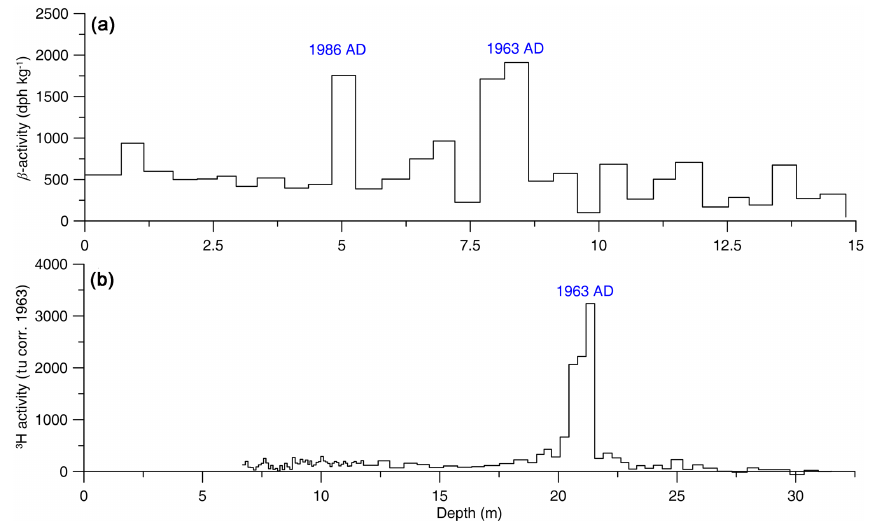
Figure 2. The β activity profile of the Chongce 58.8m Core 3 (a) and the tritium (corrected for the decay) profile of the Chongce 216.6m Core 4 (b) . TU (tritium units) is one tritium atom/1018 hydrogen